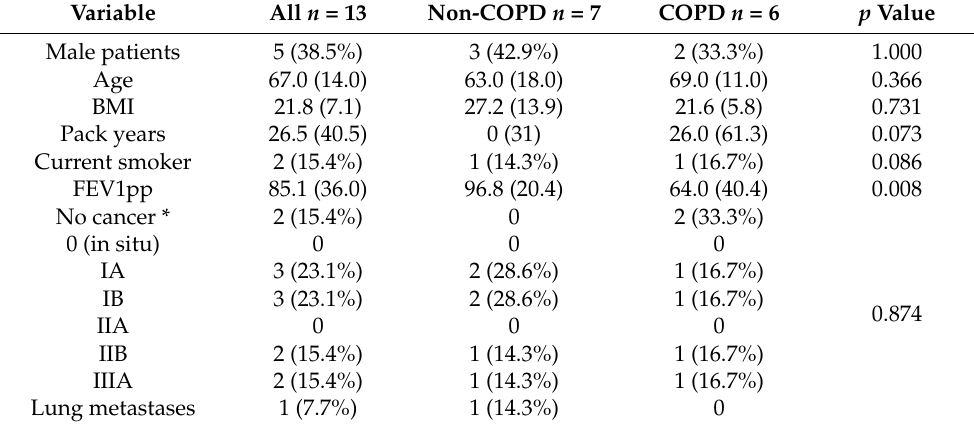
Table 1. Characteristics of the patient cohort from the miR microarray